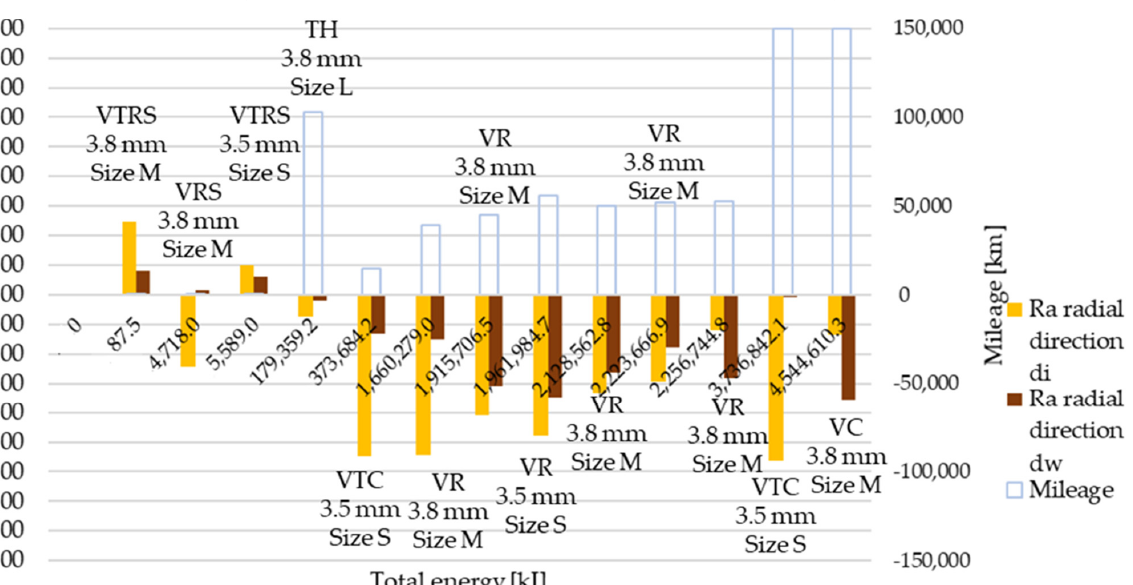
Figure 14. Deviation of Rz surface roughness values from initial conditions, radial direction.